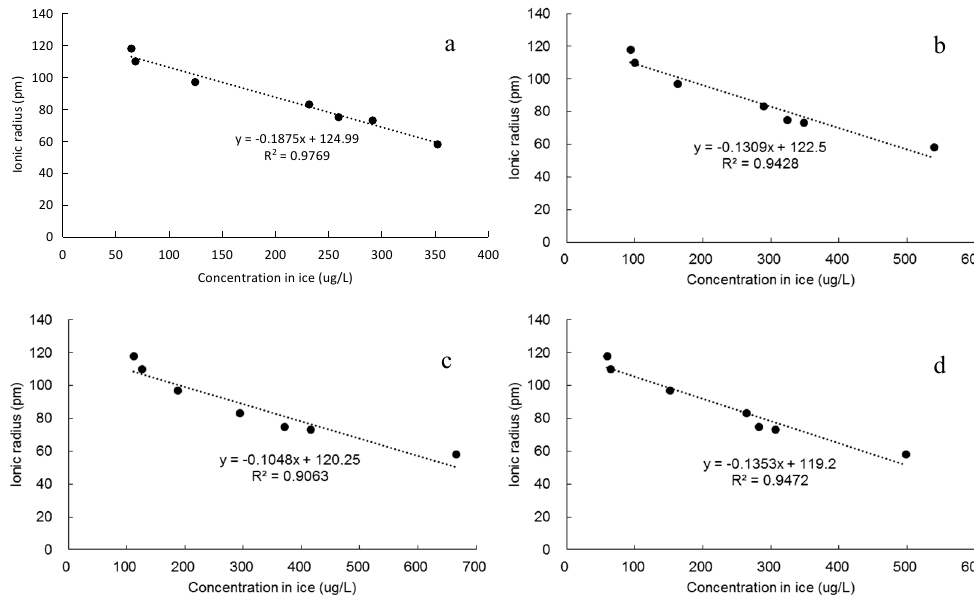
Figure 5. The relationship between concentration in ice and ionic radius (( a ) T = − 25 ◦ C, pH = 7, initial concentration is 10,000 µ g/L; ( b ) T = − 15 ◦ C, pH = 7, initial concentration is 10,000 µ g/L; ( c ) pH = 5, T = − 25 ◦ C, initial concentration is 10,000 µ g/L; ( d ) pH = 11, T = − 25 ◦ C, initial concentration is 10,000 µ g/L).